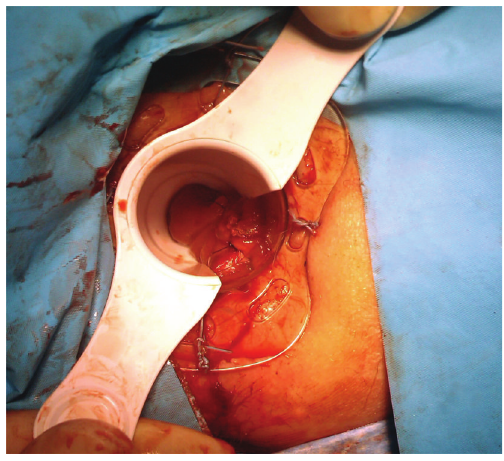
Figure 3: Final result after suturing the excisional